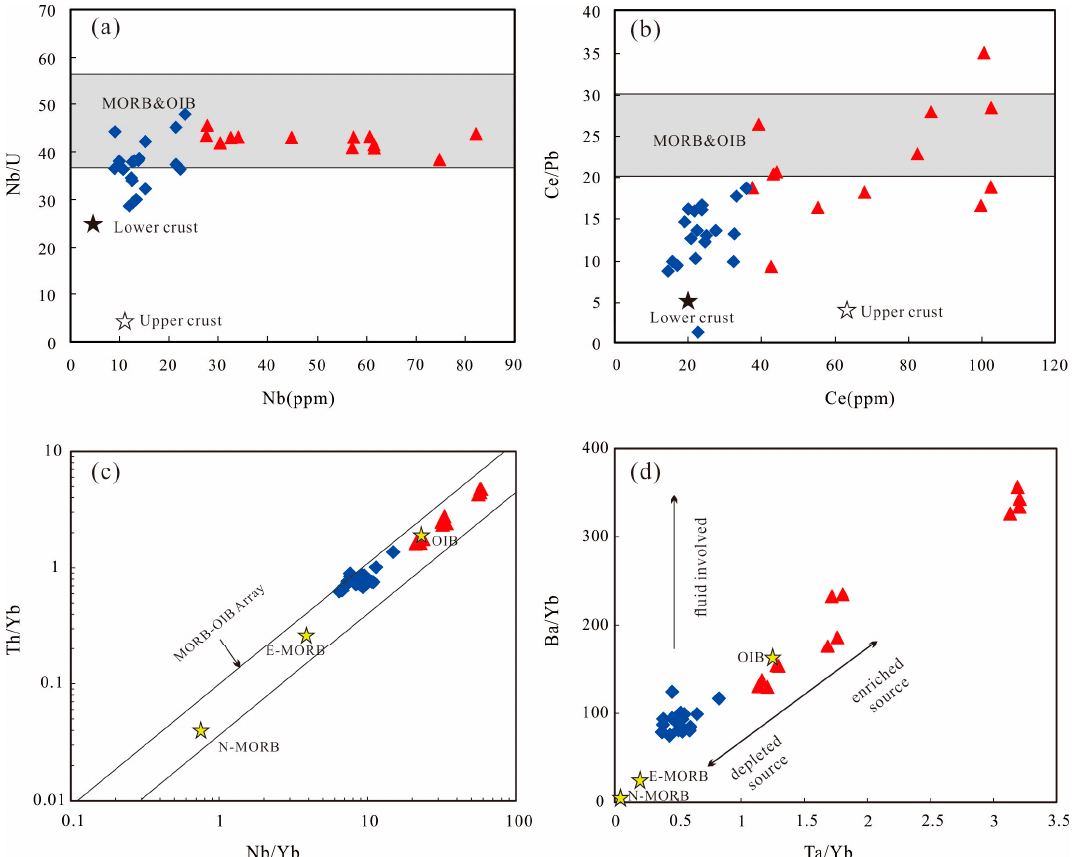
Figure 13. ( a ) Nb/U vs. Nb, ( b ) Ce/Pb vs. Ce, ( c ) Th/Yb vs. Nb/Yb, and ( d ) Ba/Yb vs. Ta/Yb diagrams for the Cenozoic Qianjiadian mafic rocks. Data for MORB and OIB are from [70], data for the upper and lower crusts are calculated after Rudnick and Gao [71], and the field of the MORB-OIB mantle array is from [72].